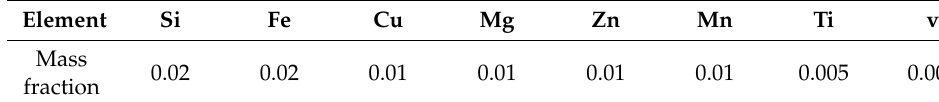
Table 2. Chemical composition of aluminum 1a90.